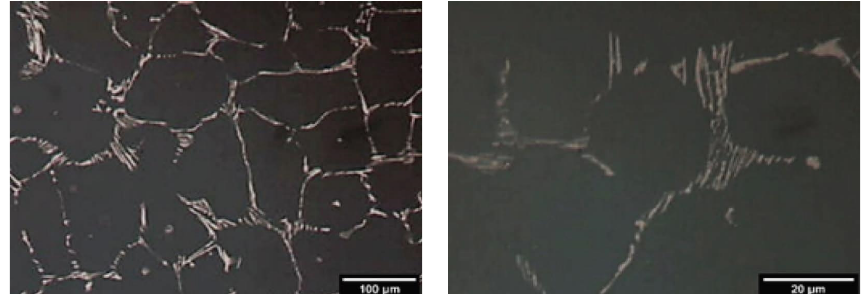
Figure 3: Microstructure of T1 high-speed tool steel in the as-cast